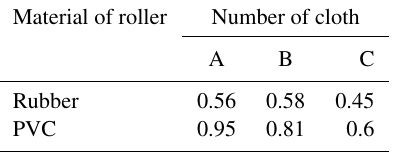
Table 2. Coefficient of friction. Material of